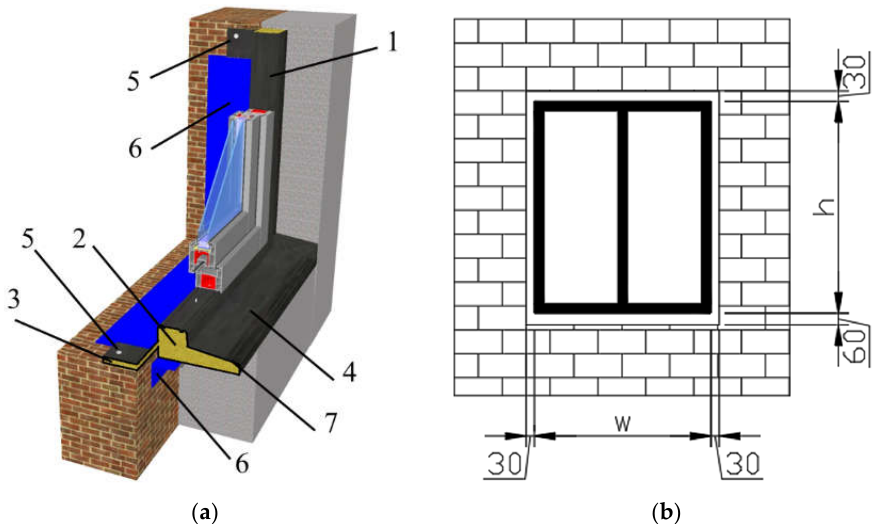
Figure 2. Analysed installation system: ( a ) components of the installation system; ( b ) dimensions of the window mounting space [36].